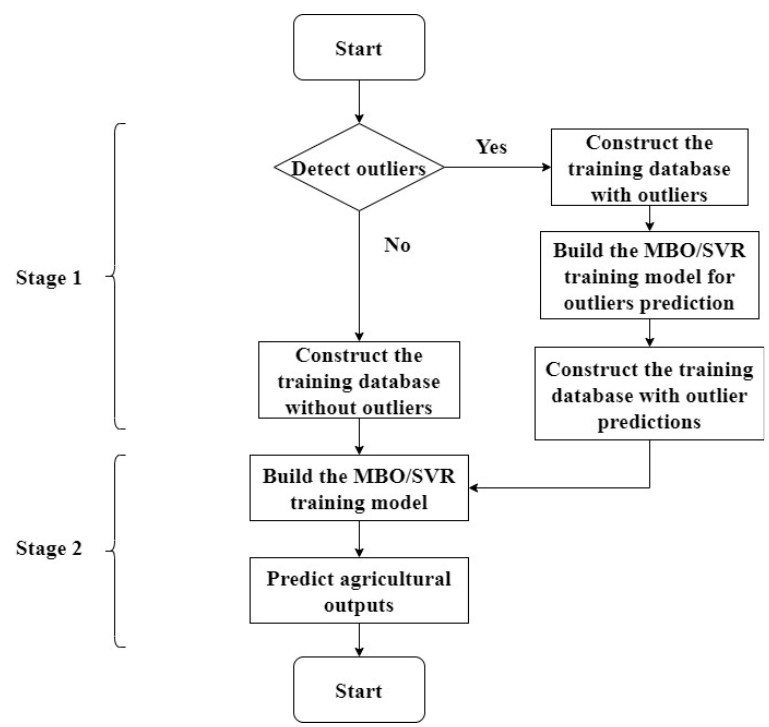
Figure 3. The flowchart of the MBO/SVR model.